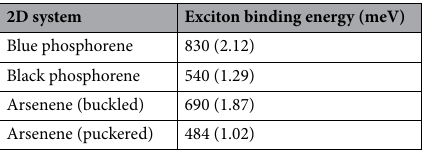
Table 3. Exciton binding energies of phosphorene and arsenene